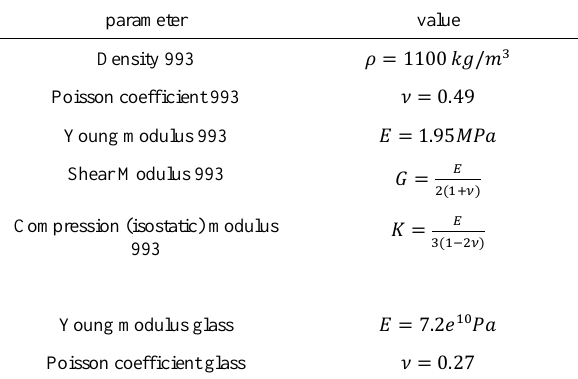
Table 2: Parameters defining silicone and glass.